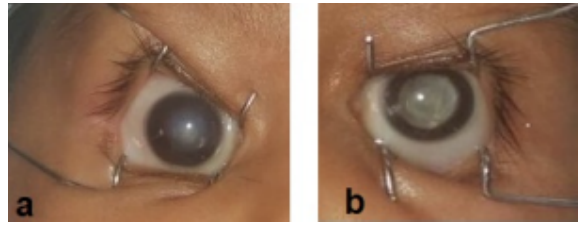
Figure 3: (a) Central corneal opacity in the right eye, (b) cataract in the left eye